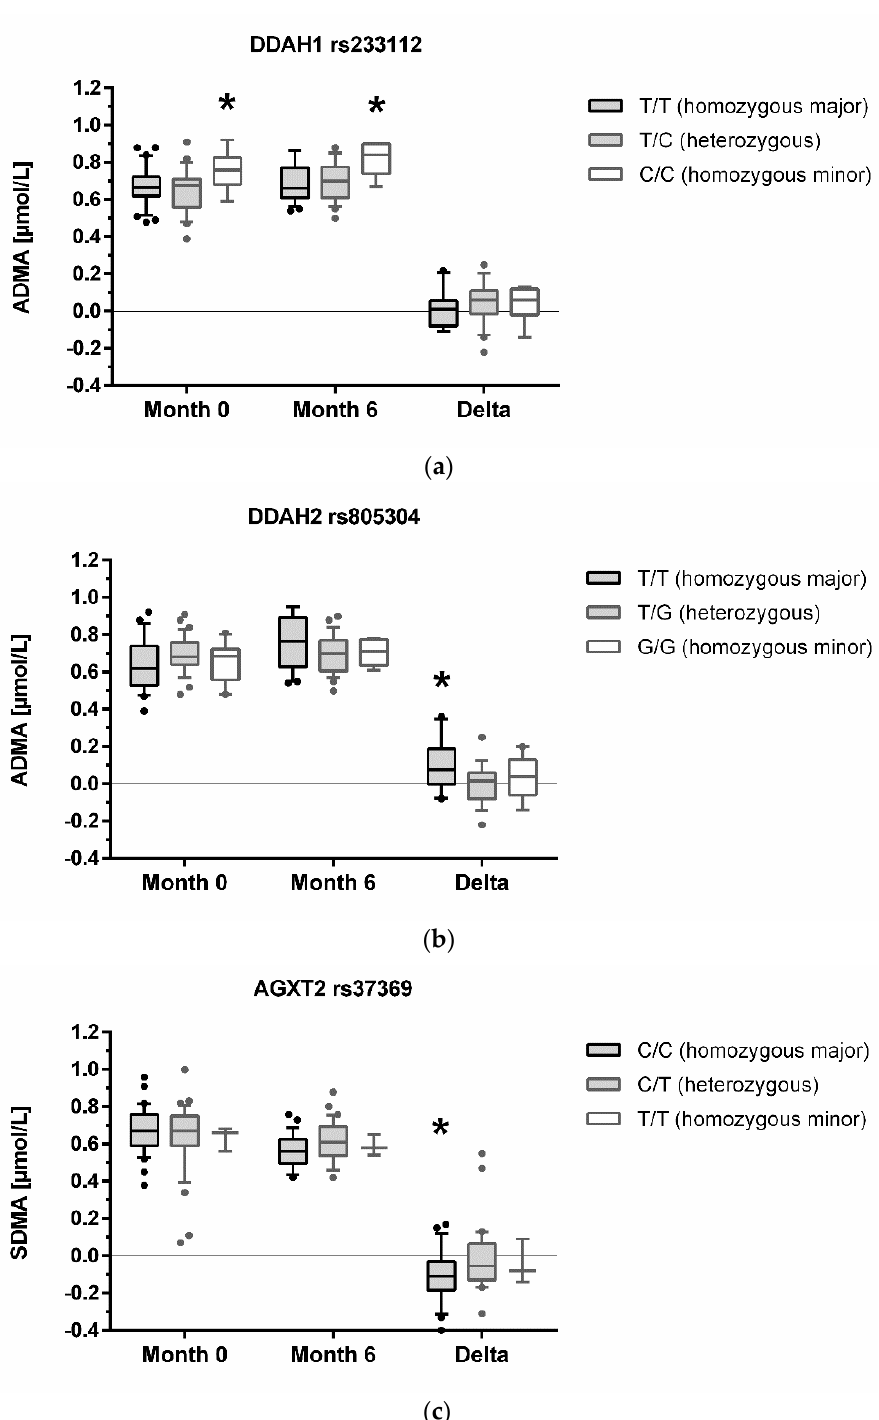
Figure 2. Dimethylarginine concentration with relation to DDAH1, DDAH2, and AGXT2 genotypes. Concentrations of ADMA at month 0 (baseline, sea level), month 6 (high altitude), and the increment of plasma ADMA concentration from month 0 to month 6 (Delta) are shown in different genotypes of DDAH1 rs233112 ( a ) and DDAH2 rs805304 ( b ). SDMA concentrations are shown in relation to AGXT2 rs37369 genotypes ( c ). Data are presented as median and interquartile range of n = 57–69 individuals, with the whiskers showing the 10th and 90th percentiles, respectively; outliers are plotted individually as dots. * denotes a statistically significant trend in differences of biomarker concentrations over genotypes (multiple comparisons ANOVA).